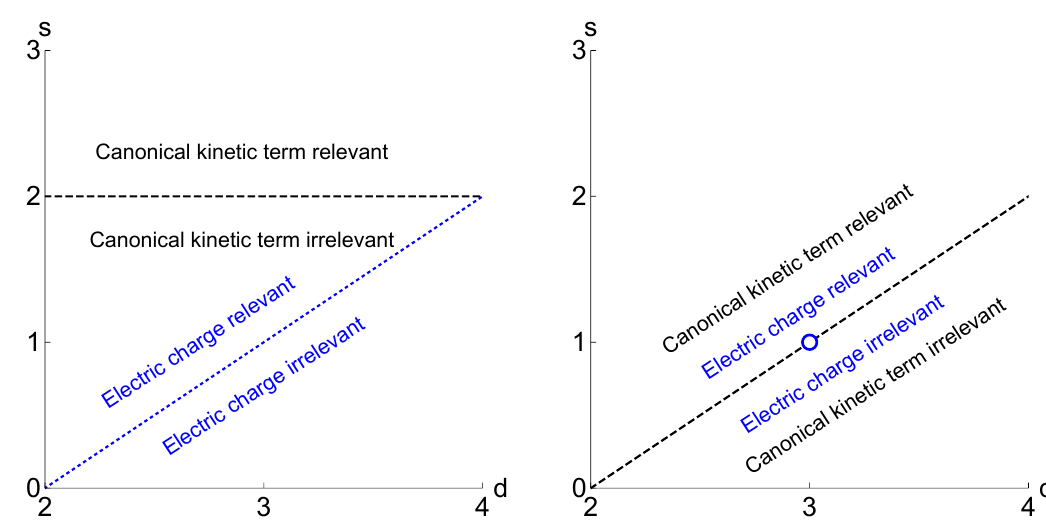
Figure 1 . Classical (left) and quantum corrected (right) scaling properties of the canonical kinetic term and electric charge for various values of s and d as computed in the main text using an epsilon expansion and extrapolated to large (cid:15) . The white circle signi(cid:12)es that the d = 3, s = 1 theory is exactly marginal, as are all theories with d = s (cid:0) 2 when d is not an even